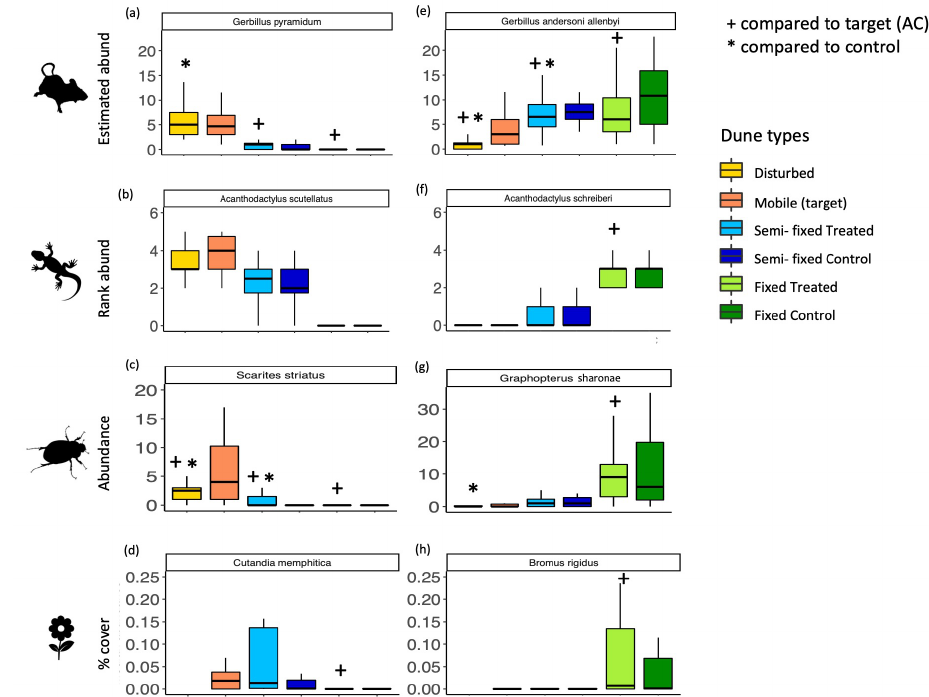
Figure 11. Boxplots of ( a – d ) Mobile dune Indicator Species (MIS) and ( e – h ) Fixed dune Indicator Speices (FIS) for each taxon (see icons by row), showing the 25% and 75% percentiles of the measure of abundance (Y axis units e.g., rank abundance / % cover) on each dune type for rodents, reptiles, beetles and annuals. Dune types were tested for significant di ff erences between treated dunes, their control pair and reference mobile dunes, using mixed e ff ect models. Disturbed dunes were tested against semi-fixed control dune and mobile dunes. Significant results ( p < 0.05) are shown for treated dunes compared to *control and + reference dunes (dune type abbreviations refer to the Nizzanim LTER coding system for